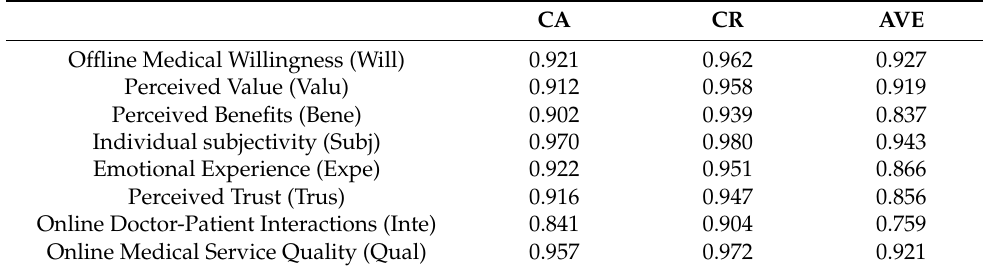
Table 2. Descriptive statistics for the constructs.